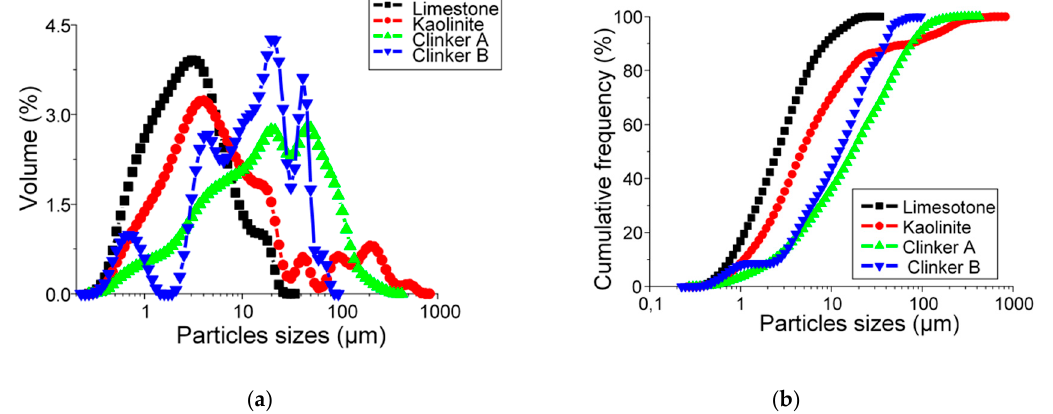
Figure 11. Particle size distribution analysis of raw limestone, raw kaolinite, clinker A and clinker B powders: ( a ) volume (%), ( b ) cumulative volume (%).